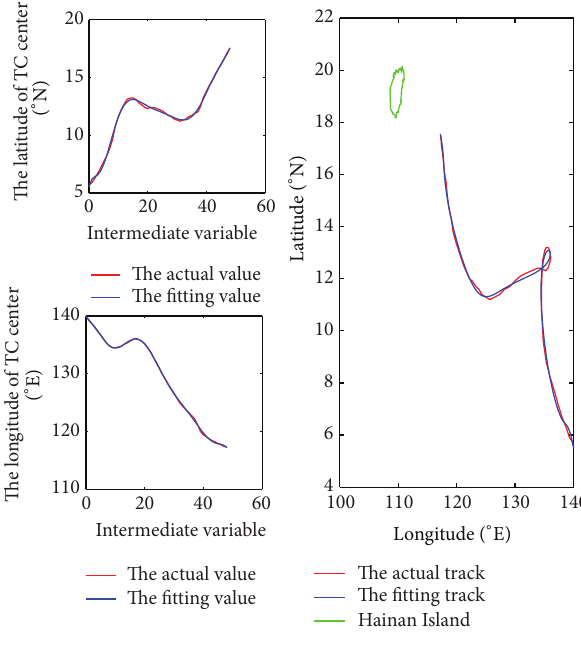
Figure 4: The curve fitting of an arbitrary TC.